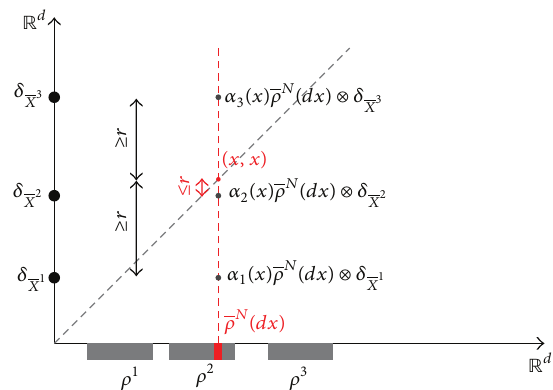
Figure 6: Transference plans (86) in R 𝑑 × R 𝑑 for 𝑁 = 3 . Each continuous mass element is within a distance 𝑟 from its corresponding Dirac mass. Therefore, owing to (81), it is farther than 𝑟 from all other Dirac masses.